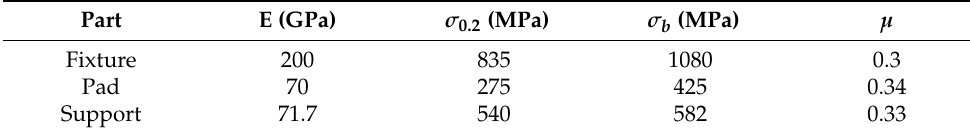
Table 2. The material parameters of the numerical